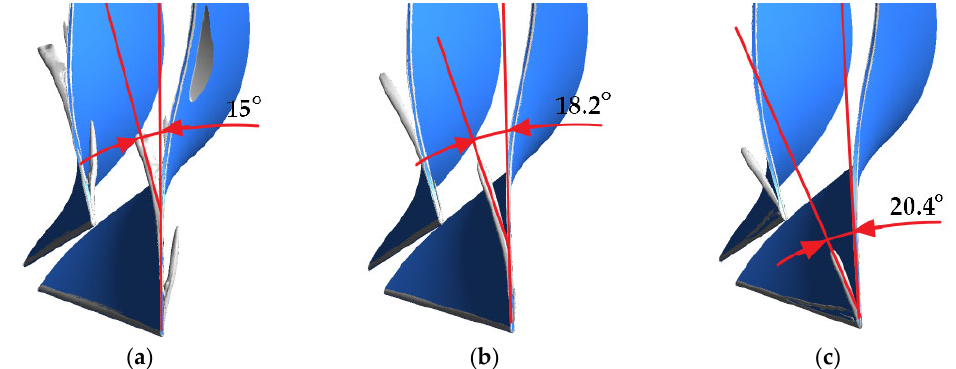
Figure 6. TLV angles under three working conditions. ( a ) S1: large margin point; ( b ) S2: design point; ( c ) S3: quasi ‐ stall point.